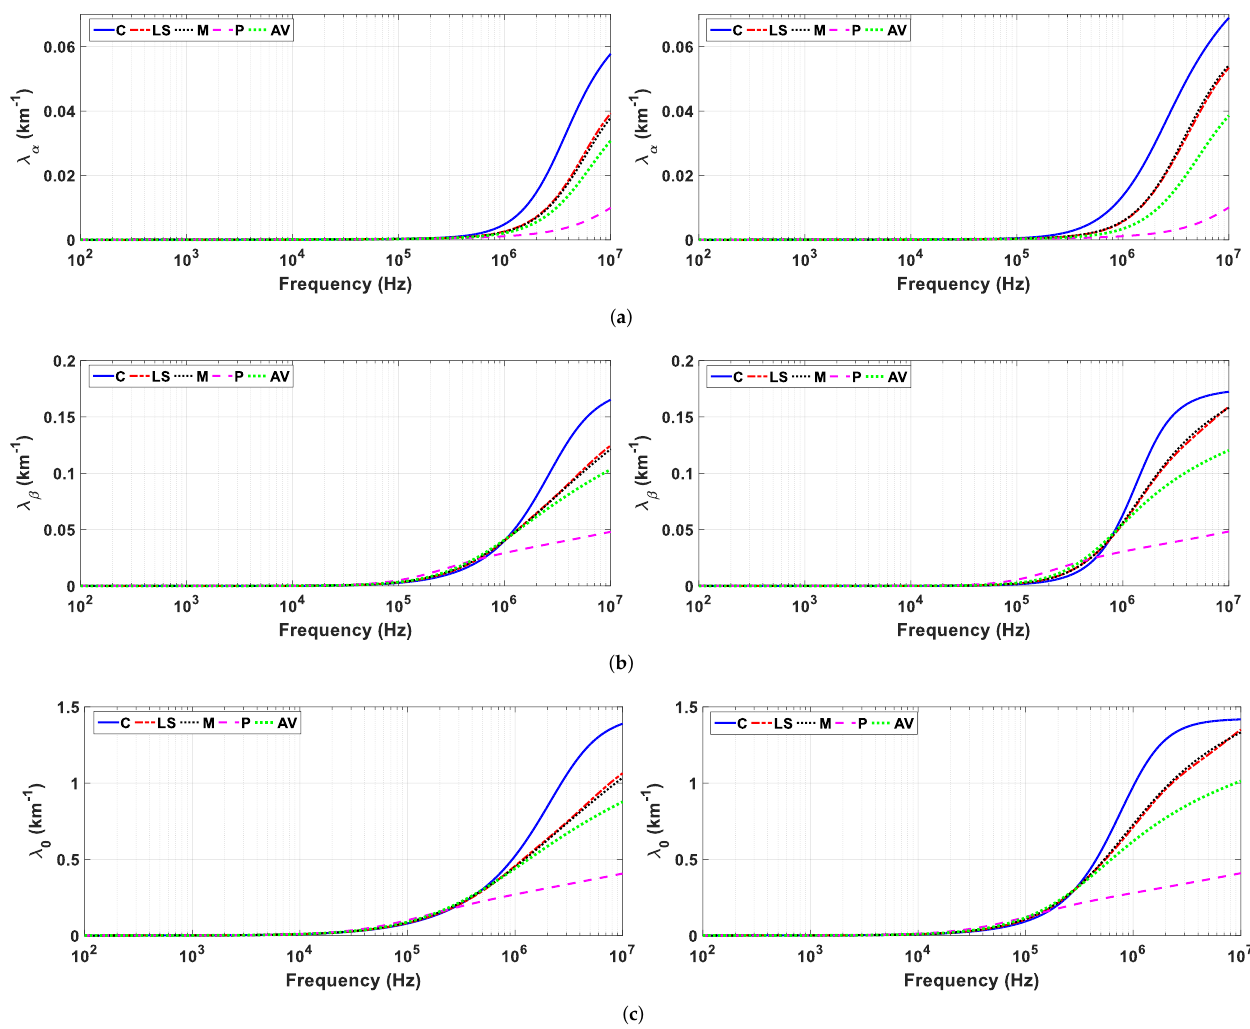
Figure 11. Attenuation constant for a soil of 700 Ω · m ( left ) and 4000 Ω · m ( right ): ( a ) mode α ; ( b ) mode β and ( c ) mode